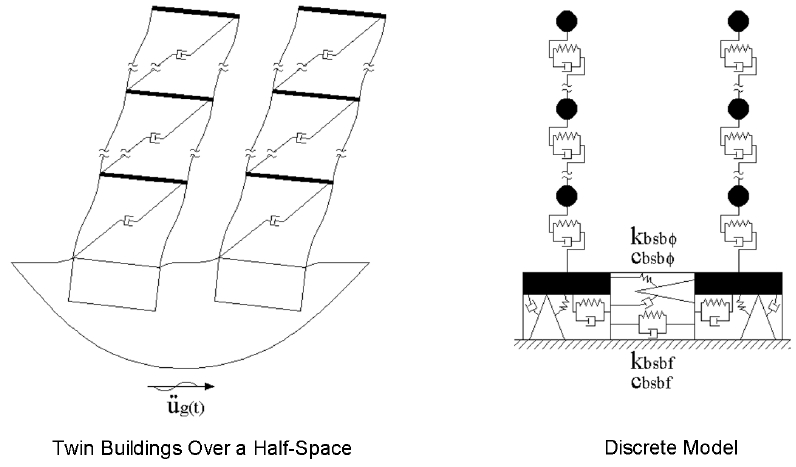
Fig. 2. Structure-soil-structure interaction of twin